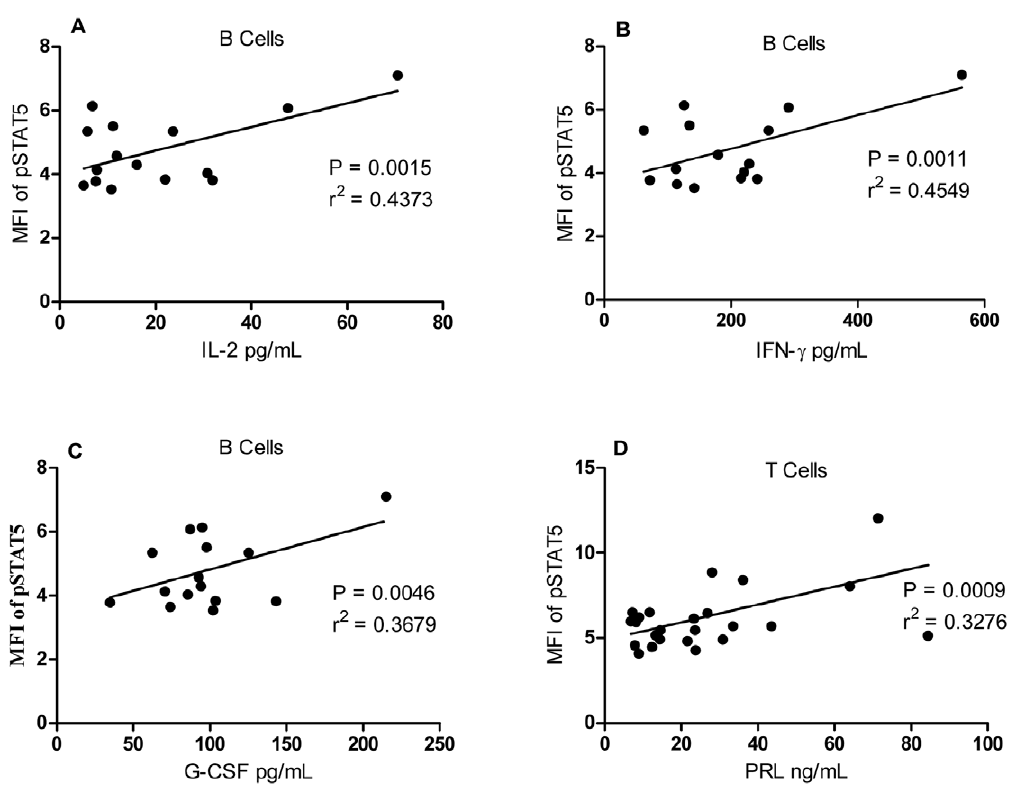
Figure 5. Association between the mean fluorescence index (MFI) of pSTAT5 in B cells and cytokine levels in SLE patients. The concentrations of serum IL2 (A), IFN c (B) and G-CSF (C),correlated positively with the MFI of STAT5 in the B cells of SLE patients. (D) The serum prolactin concentration correlated positively with the MFI of pSTAT5 in the T cells of SLE patients. MFI, mean fluorescence index; IL, interleukin; IFN c , interferon c ; G-CSF, granulocyte colony-stimulating factor; PRL,